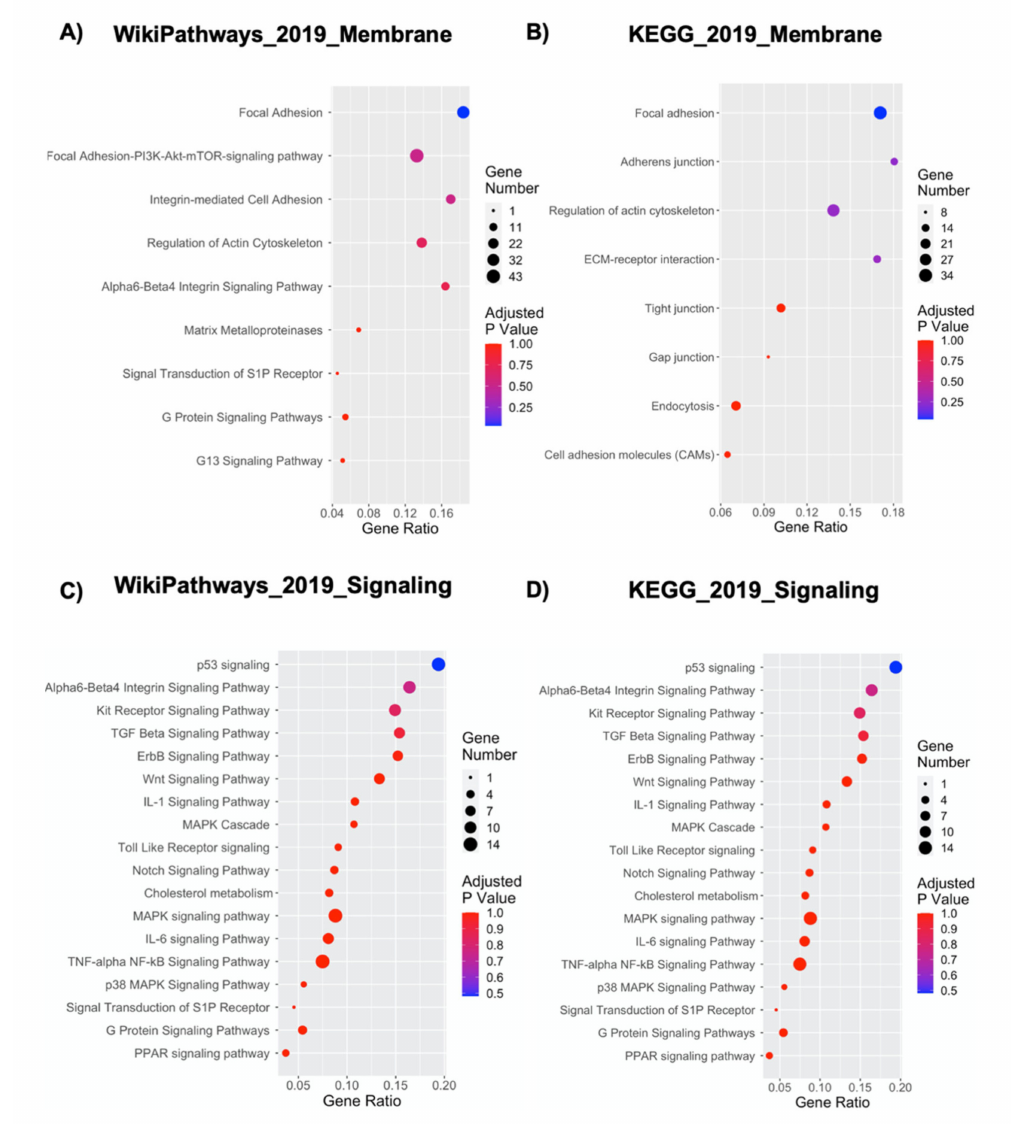
Figure 4. Deregulated pathways and genes correlated with membrane and signal transduction processes. WikiPathways analysis ( A ) and KEGG analysis ( B ) highlighted nine and eight deregulated pathways, respectively, for membrane processes. WikiPathways analysis ( C ) and KEGG analysis ( D ) highlighted 18 and 29 deregulated pathways, respectively, for signal transduction. The y-axis represents the name of the pathway, the x-axis represents the Rich factor, dot size represents the number of di ff erent genes, and the color indicates the adjusted p